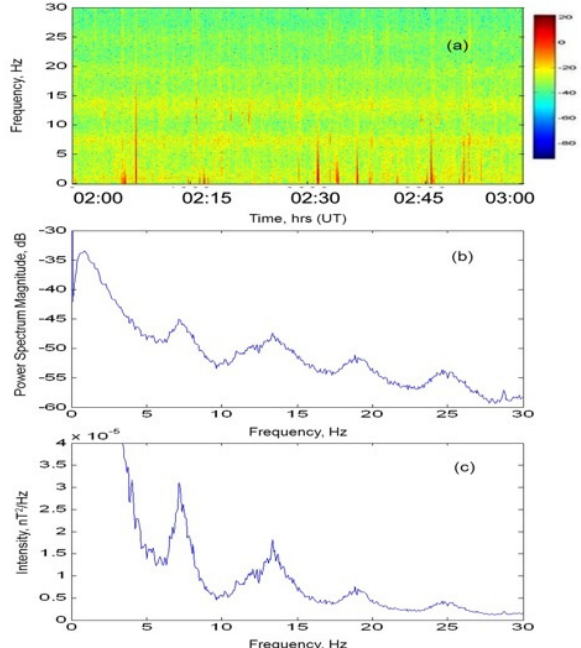
Figure 1. (a) Frequency-time spectrogram of the ULF/ELF data recorded on 18 February, 2012 at Agra showing four Schumann res- onance lines (b) Power spectrum density (PSD) of the data in Fig- ure 1a and (c) corresponding intensity-frequency